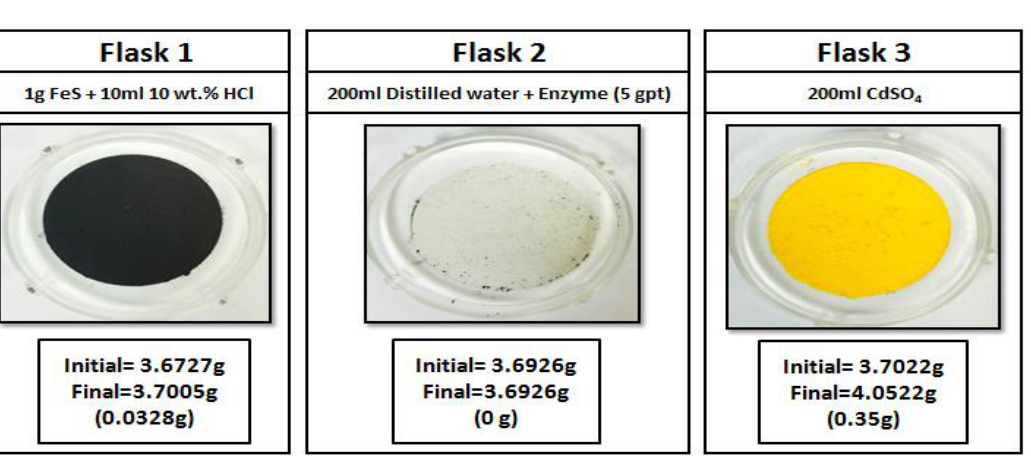
Figure 17. Enzyme gel breaker interactions in a sour environment for 4 h at 77 °F.